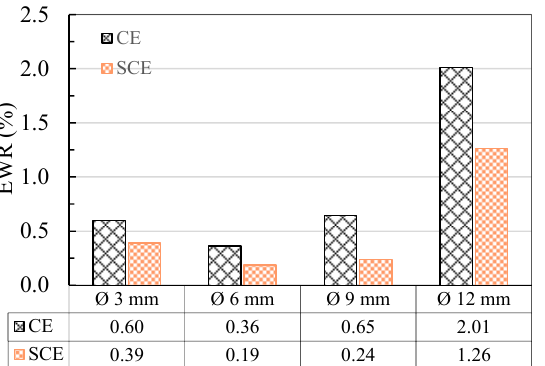
Figure 7. Electrode wear ratio of holes drilled with the conventional electrode (CE) and the step cylindrical electrode (SCE).